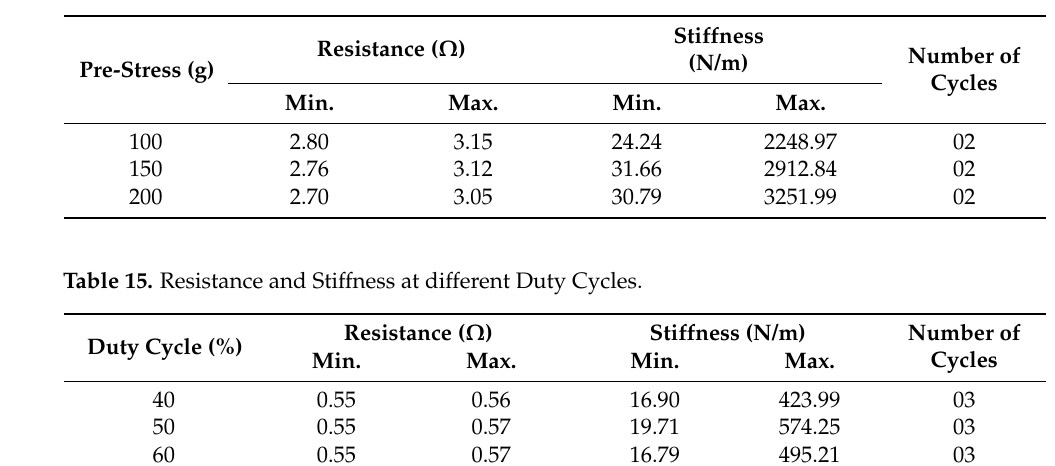
Table 16. Resistance and stiffness values at different Influencing factors.